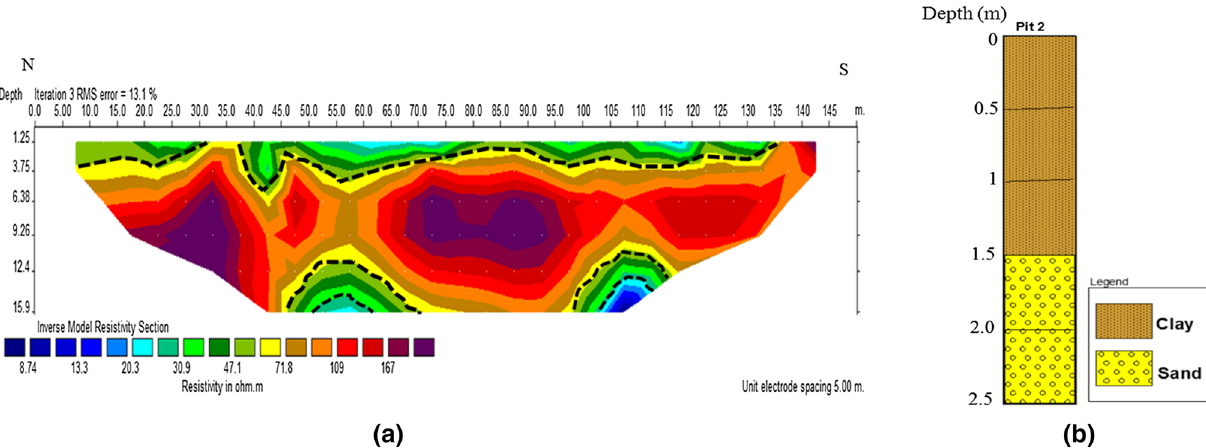
Fig. 5 Profile 2: a pseudosection of profile 2, b soil profile in pit 2